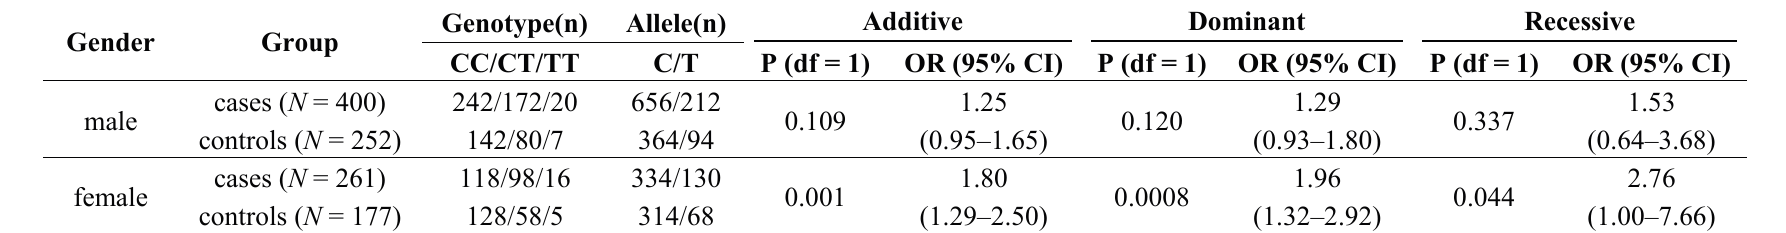
Table 3. Association of ACP1 rs3828329 with CAD in different gender.